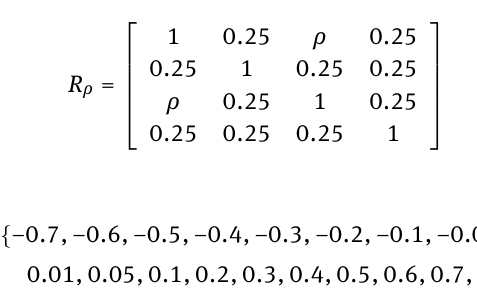
Figure 1: Impact of the dependence between X 1, t and X 2, t , as measured by the average length of the prediction intervals in panel (a). The plain line gives the value of ML α N and the dashed gives the value of (cid:99) ML served values outside of prediction intervals. The circles give the results for prediction intervals based on univariate series while plus signs are for prediction intervals based on bivariate series, and the horizontal lines give the 95% confidence inter- val. For both panels, the x-axis gives the Kendall’s tau between X 1, t and X 2, t